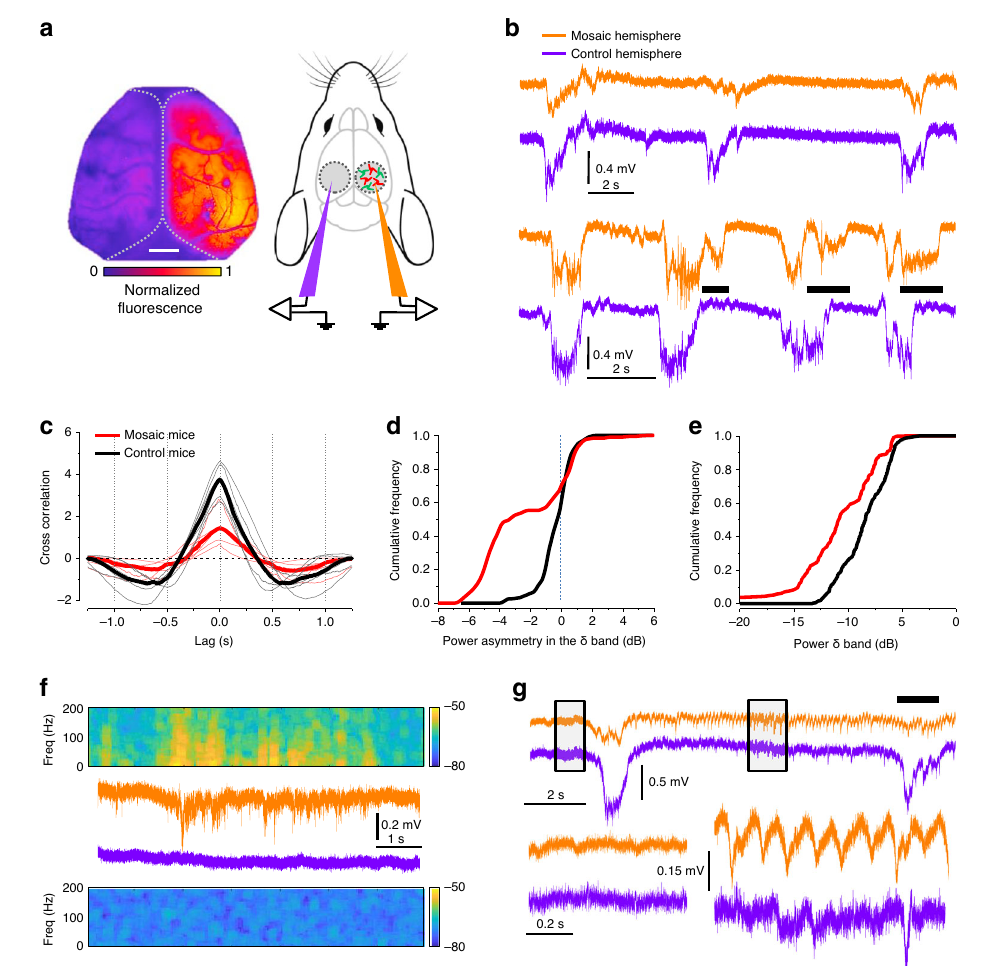
Fig. 6 Electrophysiological impairment of the resting state EEG in the PTEN-KO mosaic. a LFP is recorded at the center of the PTEN mosaic, as identi fi ed by wide- fi eld imaging of Beatrix fl uorescence (scale bar 1 mm), and in the corresponding site in the contralateral hemisphere in layers 2/3. b SWO recorded in the PTEN mosaic and in the control site in two different mice. The data show two forms of SWO anomaly: in the upper example, the PTEN mosaic exhibits a large reduction in amplitude, in the lower example, the amplitude is normal, but the timing of the oscillation is altered with long tails of activity (black bars). c The loss of interhemispheric synchrony is demonstrated by the cross-correlation spectra of the LFP recorded in the two hemispheres of control and PTEN mosaic mice ( n = 6 control mice, n = 6 mosaic mice). Each thin line reports the spectra of an individual mouse and the thick line is the median spectra. The two groups of spectra are signi fi cantly different ( p < 0.05, two-sided Mann – Whitney U test). d Power difference in the delta band (0.5 – 4 Hz) between the two channels for the entire sample ( p < 0.01, two-sided Kolmogorov – Smirnov test). e The amplitude of upstates in the control side of mosaic mice is impaired as demonstrated by the lower power measured in the δ band of individual oscillations ( p < 0.01, two-sided Kolmogorov-Smirnov test). f Epileptiform burst occurring in the PTEN mosaic during a downstate. g Epileptiform burst formed by regular hypersynchronous spikes occurring in the PTEN mosaic. The dashed boxes indicate the areas magni fi ed below. On the left, it can be appreciated how physiological down states are devoid of any signi fi cative activity. During the burst, however, the mosaic side exhibits periodic sharp spikes occurring at a frequency of about 5 – 10 Hz. These bursts are never observed in control mice. This activity suppresses regular SWO in the PTEN mosaic (black